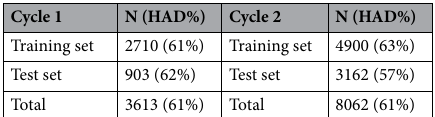
Table 8. Distribution HAD visits in IPD data